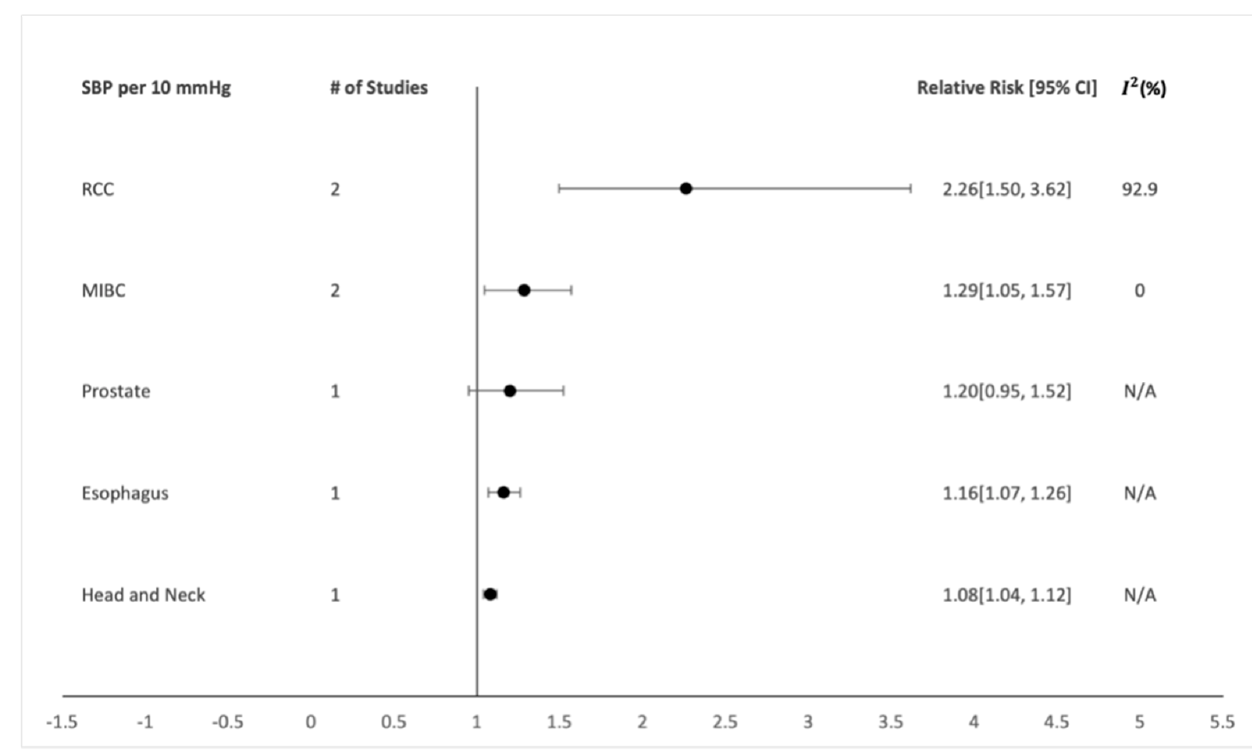
Figure 2. The summary of the relative risks, 95% confidence intervals, and heterogeneity for each individual organ − specific cancer site.